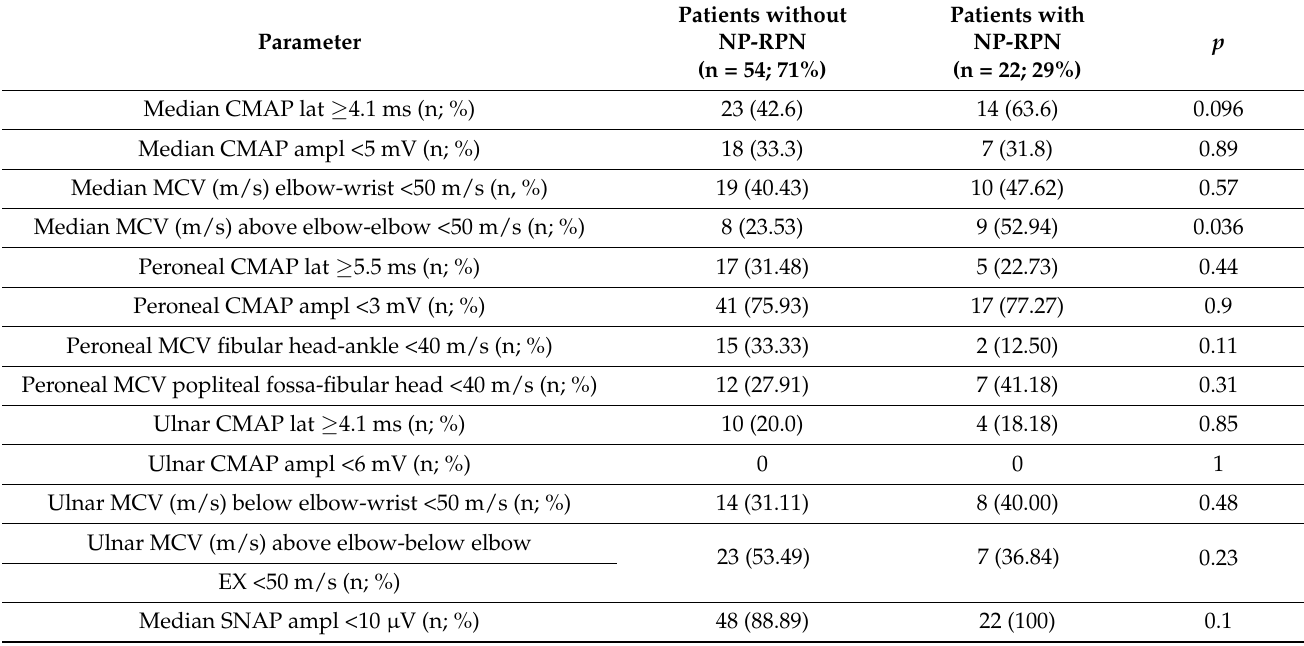
Table 4. Number and percentage of patients with abnormal values of electrophysiological parameters among those without and with